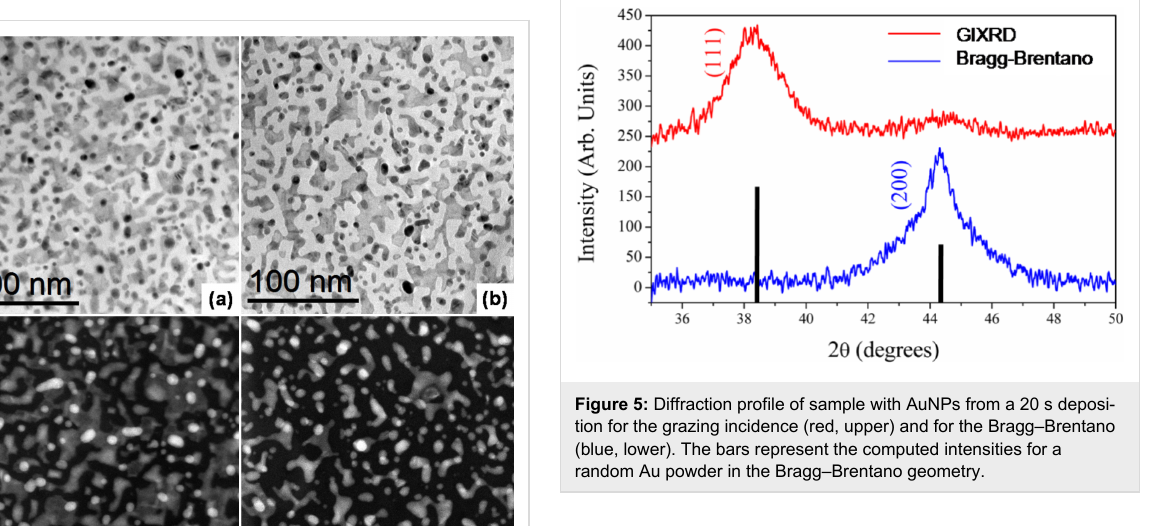
Moreover, the shape of the (200) diffraction peak indicates